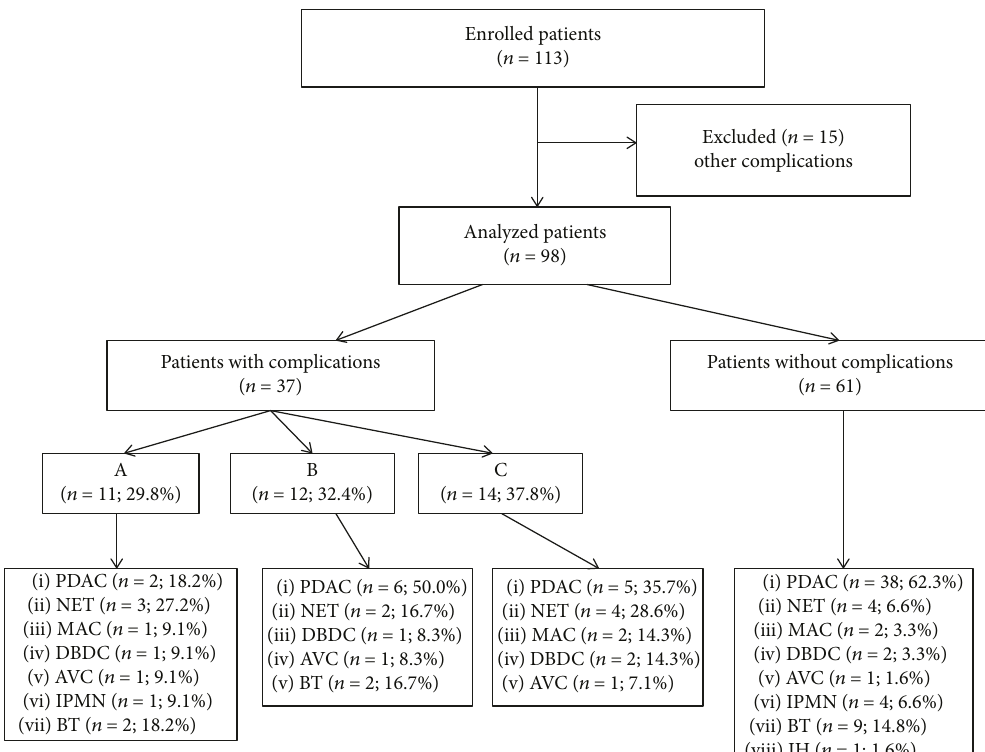
Figure 1: Distributions of malignant and benign tumors among patients with evaluated biomarker kinetics (PDAC: pancreatic ductal adenocarcinoma; NET: pancreatic neuroendocrine tumor; MAC: mucinous cystadenocarcinoma; AVC: ampulla of Vater carcinoma; DBDC: distal bile duct carcinoma; IPMN: intraductal papillary mucinous neoplasm; BT: benign tumor; IH: inconclusive